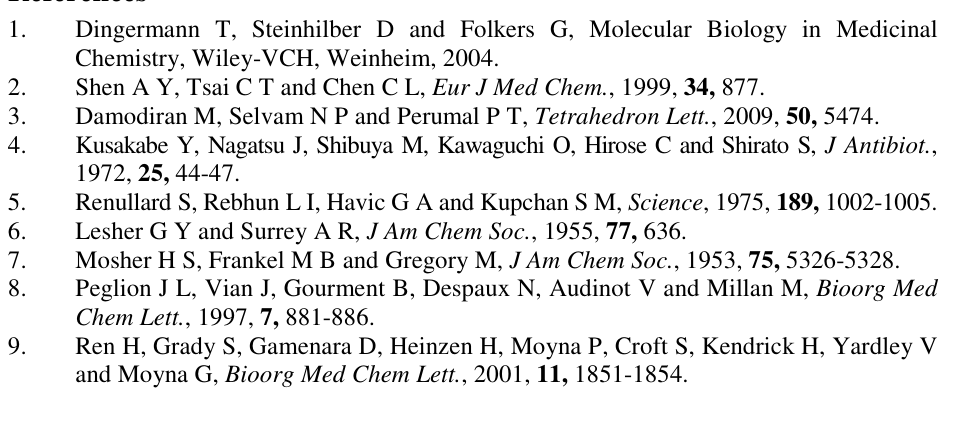
PMo O .xH O/SiO with those obtained by the recently 3 12 40 2 2